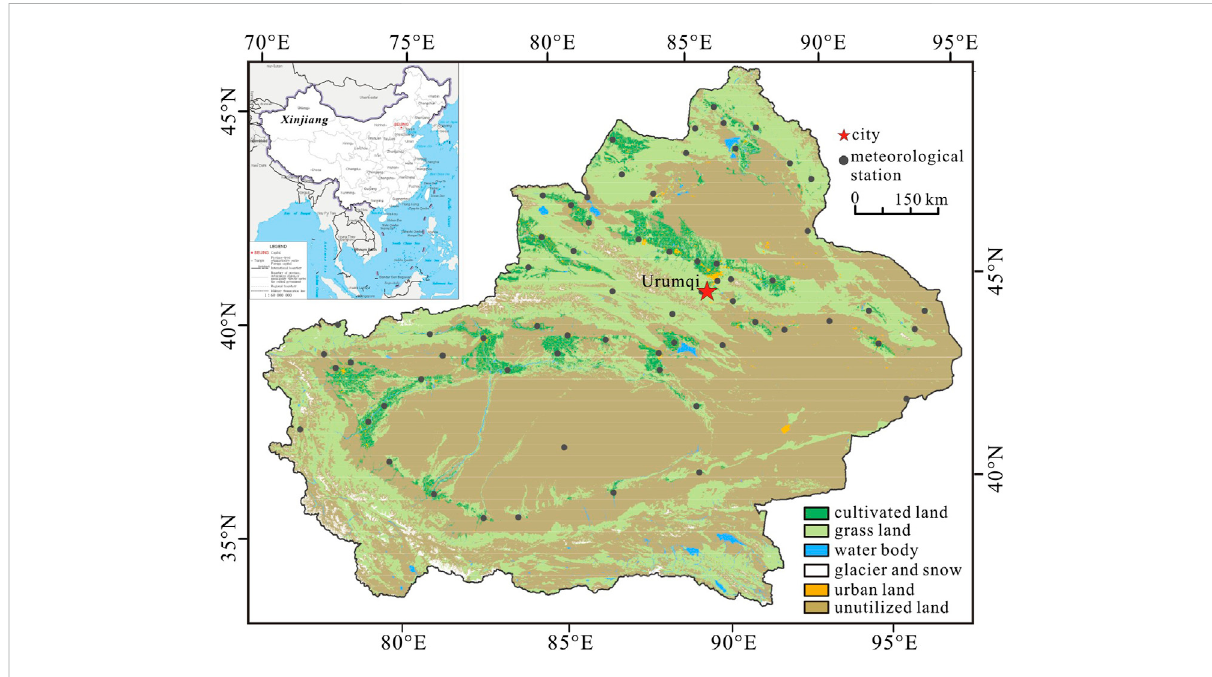
FIGURE 1 Distribution of farmlands and meteorological stations in Xinjiang,